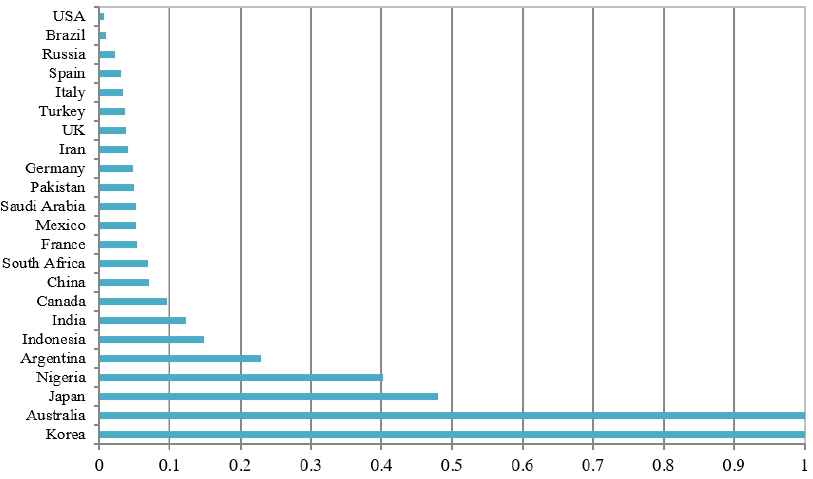
Figure 1. Mitigation efficiency scores among the 23 countries.